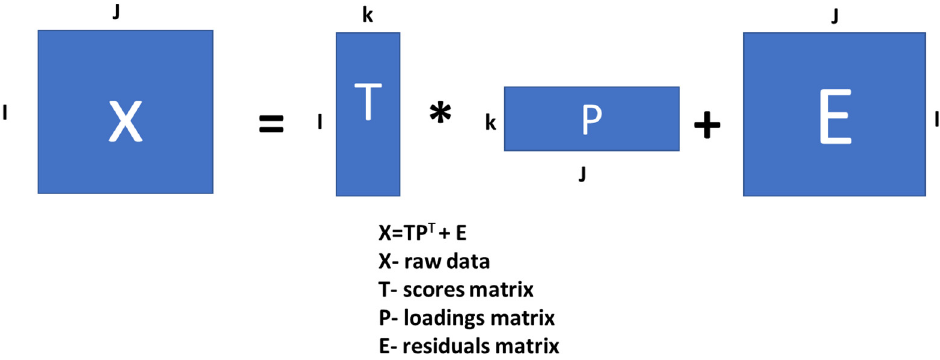
Figure 4. Representation of principal component analysis applied to µXRF data.